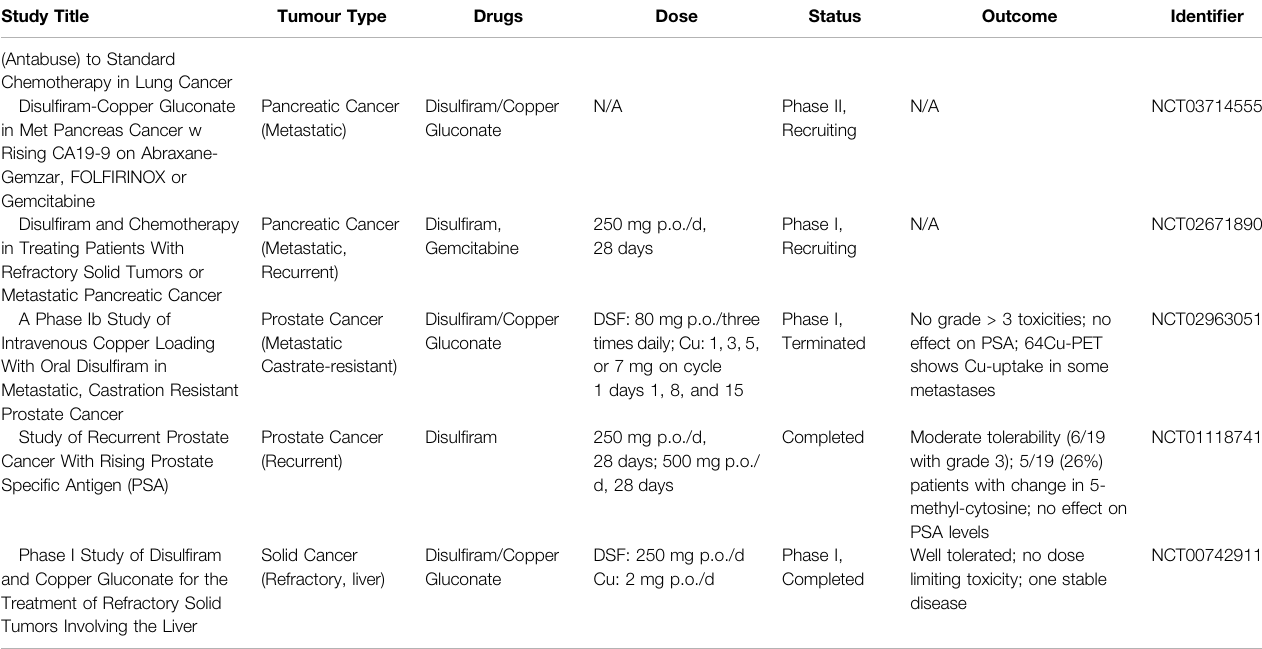
TABLE 2 | ( Continued ) Summary of clinical trials using disul fi ram for cancer